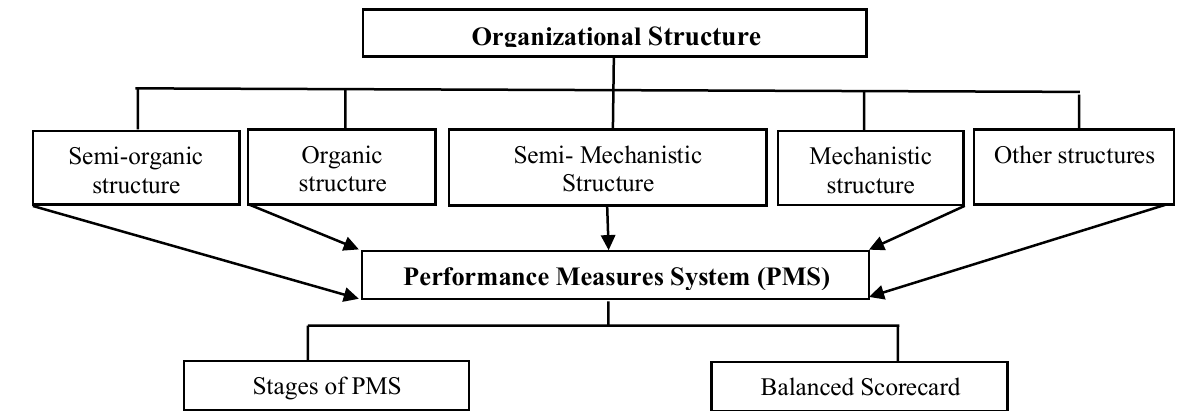
Figure 2 . Conceptual Model of the relationship between research variables Material and